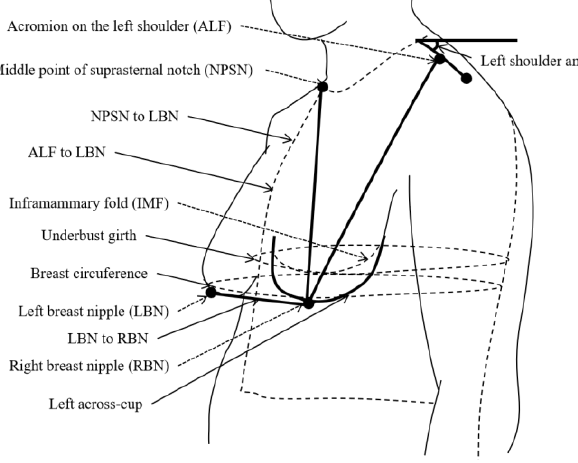
Figure 1. The anthropometric measurement of breast-related parameters.